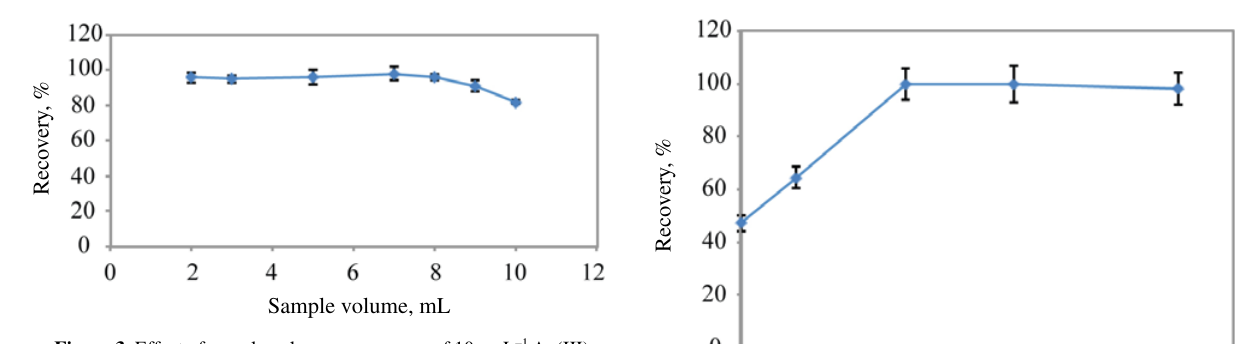
Figure 3. Effect of sample volume on recovery of 10 μg L –1 Au(III) ions as ion pair complex (n:4)